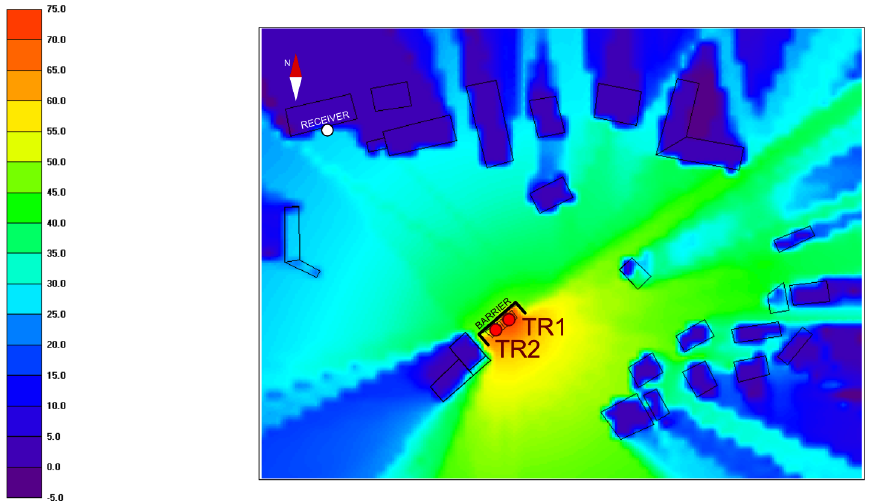
Figure 17. Predicted overall A-weighted SPL distribution in the investigated area, 4 m above the ground, after the installation of the baffled